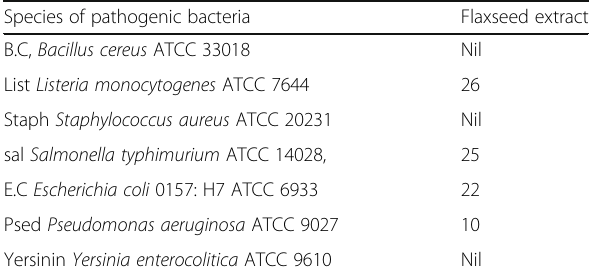
Table 3 The antimicrobial activity of FM phenolic extracts